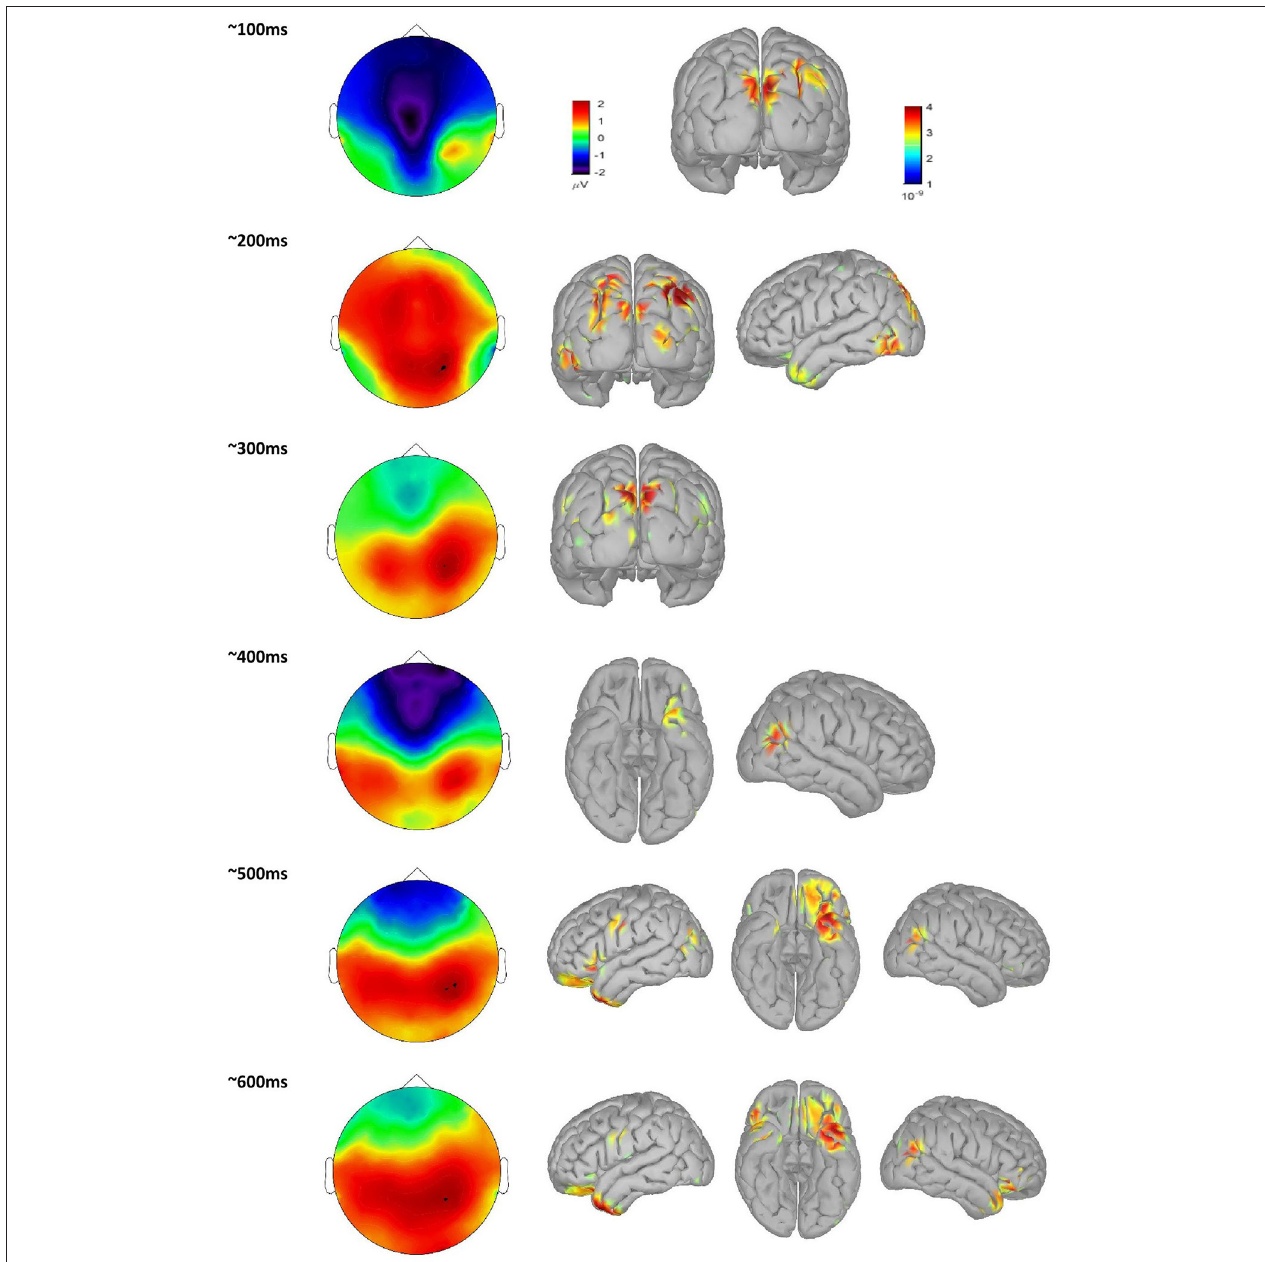
FIGURE 4 | scalp plot of time course of single word processing averaged over all groups, with associated source localization